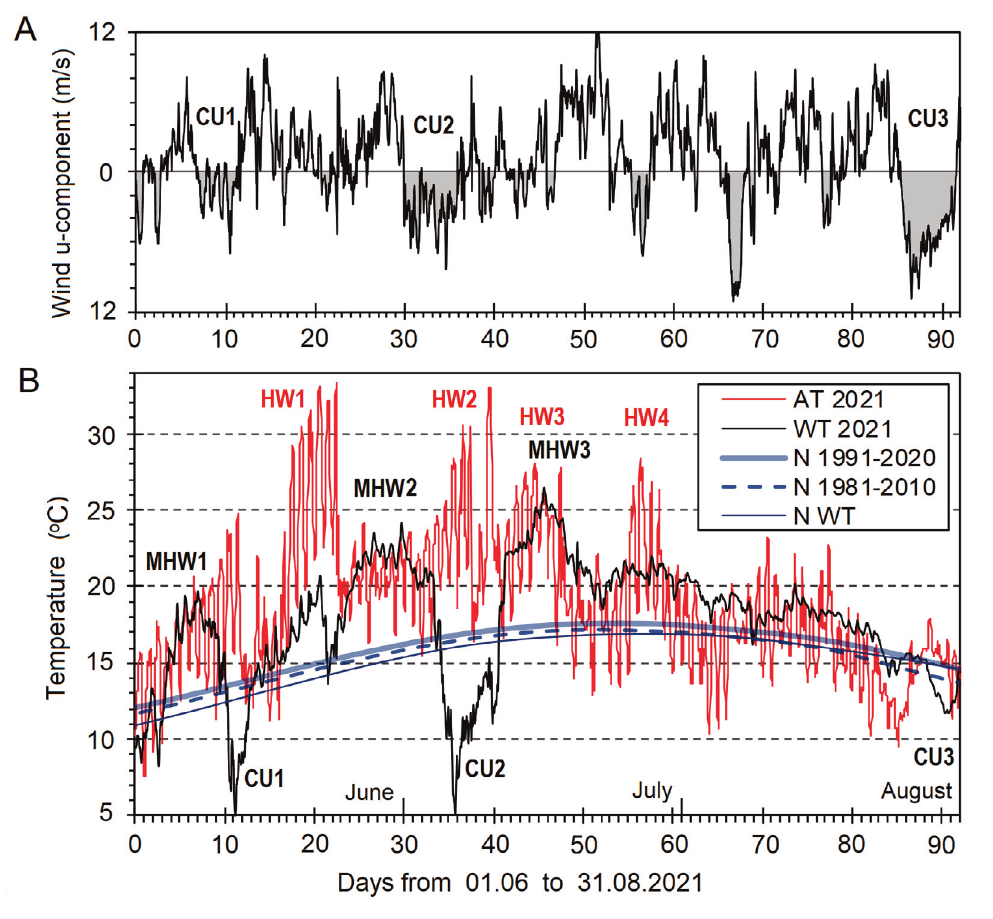
Fig. 5. A , variations in the wind velocity u -component (E direction positive) at the Kunda station. B , variations in air (AT) and water (WT) temperatures at the Kunda station in summer 2021 together with long-term norms in air temperatures (N 1991–2020, N 1981– 2010; interpolated EWS data) and Kunda water temperatures (N WT, interpolated data from Astok & Mardiste 1995). Heat wave (HW), marine heat wave (MHW) and coastal upwelling (CU) episodes are marked on the graphs.